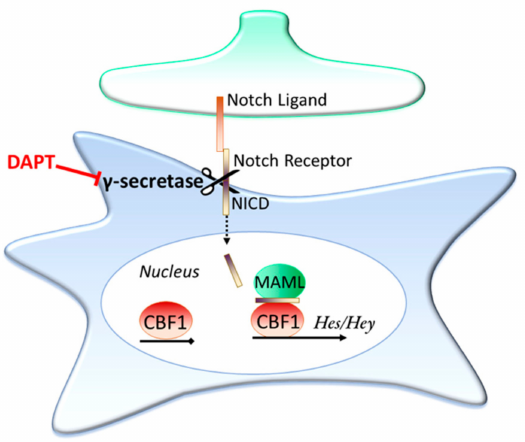
Figure 2. The Notch signalling pathway. Notch is a contact dependent signalling pathway. When a Notch ligand contacts a Notch receptor this initiates a cleavage event through the enzyme γ -secretase, releasing the Notch intracellular domain (NICD). The NICD then translocates into the cell nucleus, where it pulls down various proteins, such as MAML, and associates with the Notch e ff ector, CBF1. This association turns on transcription, with the Hes and Hey family of genes prominent examples of genes transcribed by this cascade. The γ -secretase inhibitor DAPT is able to prevent activation of the Notch signalling pathway as the NICD is unable to be